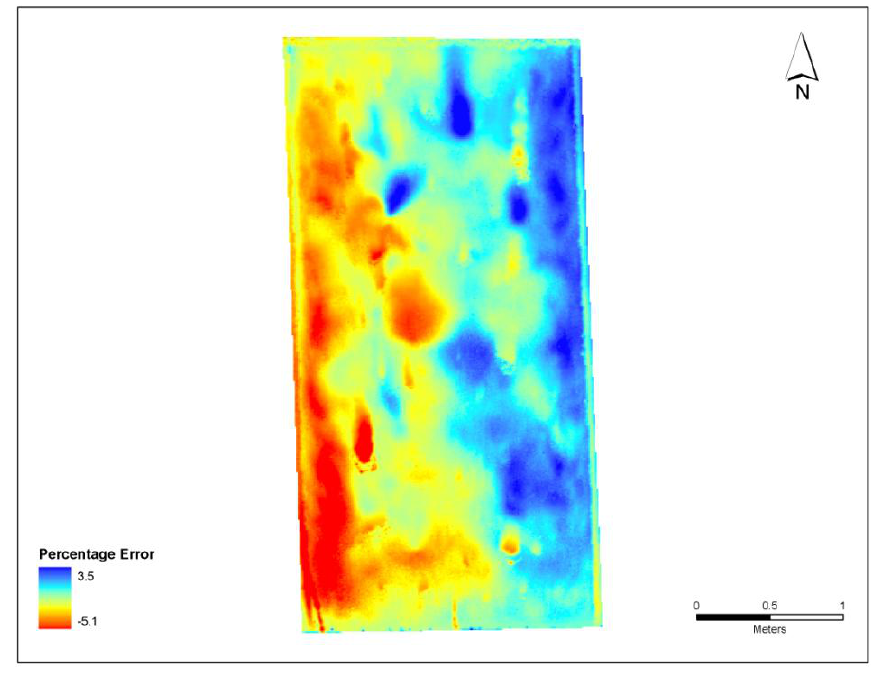
Figure 10 . Percent error map for the final DEM. Dark blue areas indicate an error of 3.5% (4.9 mm) while dark red areas indicate an error of −5% (7.5 mm). Yellow to light blue areas show areas of negligible